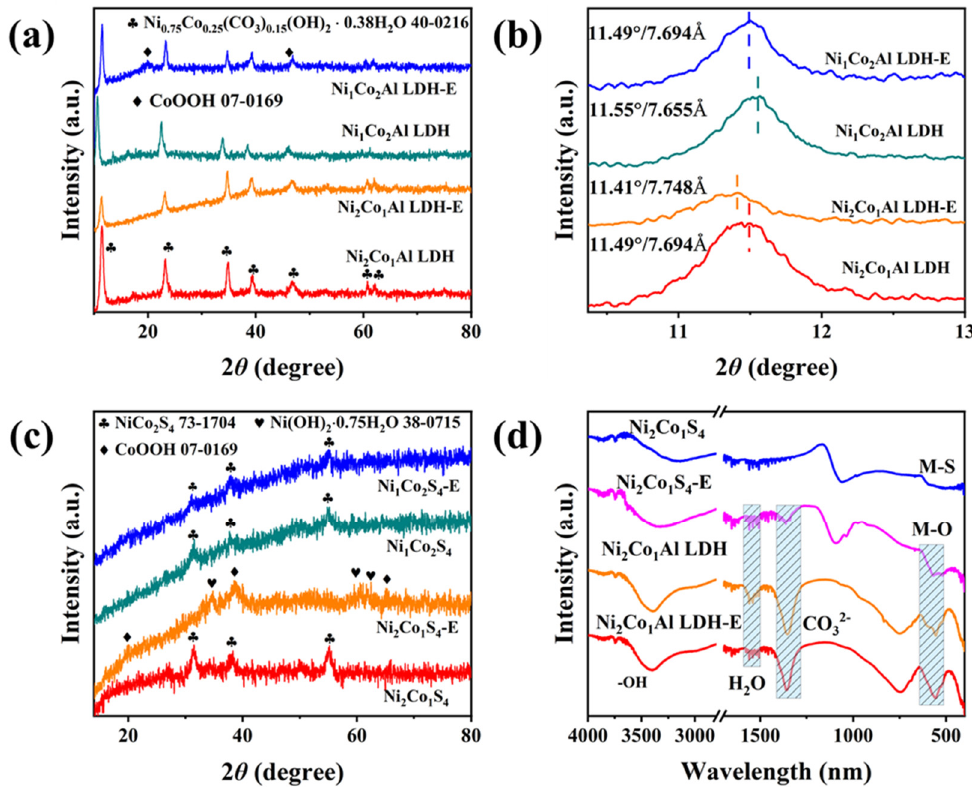
Figure 1. ( a ) The XRD patterns of Ni 1 Co 2 Al LDH, Ni 1 Co 2 Al LDH-E, Ni 2 Co 1 Al LDH, and Ni 2 Co 1 Al LDH-E; ( b ) the partial enlarged drawing of ( a , c ) the XRD patterns of Ni 2 Co 1 S 4 , Ni 2 Co 1 S 4 -E, Ni 1 Co 2 S 4 and Ni 1 Co 2 S 4 -E; ( d ) the FTIR spectra of Ni 2 Co 1 Al LDH, Ni 2 Co 1 Al LDH-E, Ni 2 Co 1 S 4 and Ni 2 Co 1 S 4 -E.